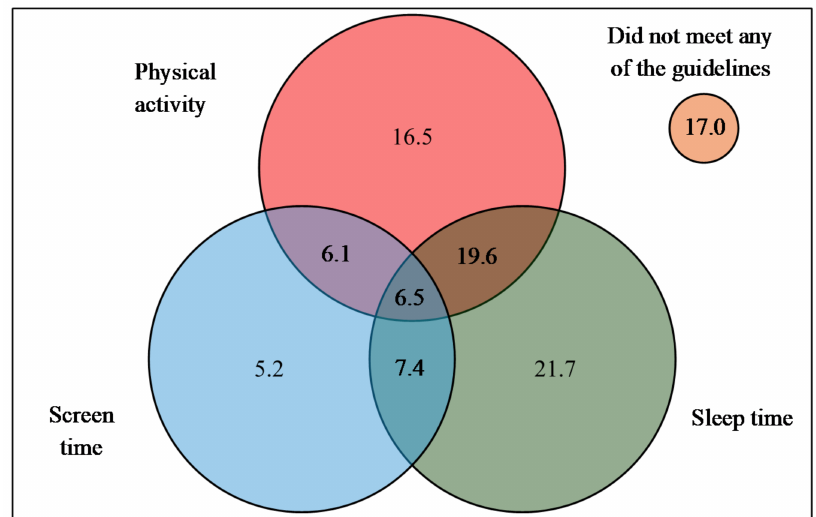
Figure 1. Proportion of preschoolers meeting physical activity, screen time and sleep guidelines. Met physical activity guidelines: ≥ 3 h total physical activity with at least an hour of MVPA for children aged 4 years and ≥ an hour of MVPA for children aged 5 to 6 years; met screen time guidelines: ≤ 60 min for children aged 4 years and ≤ 120 min for children aged 5 to 6 years; and met